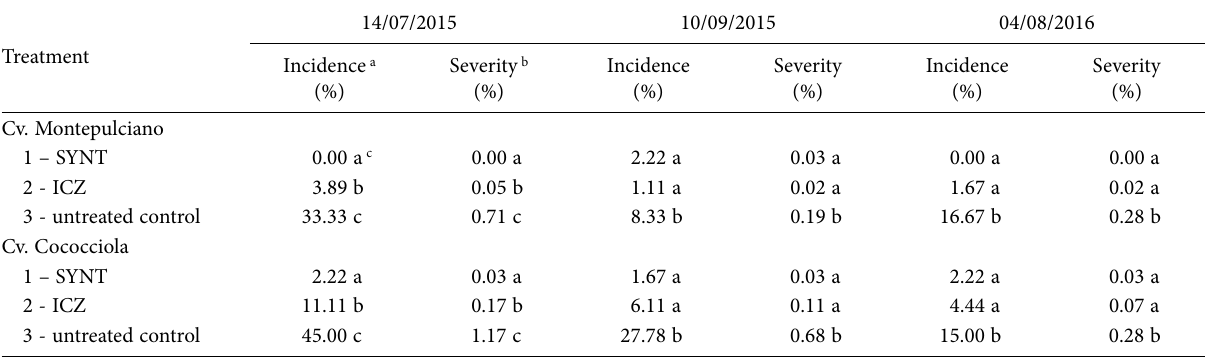
Table 8. Activity of Italian chabasite-rich zeolitites (ICZ) and synthetic insecticides (SYNT) on grapevine moth bunch infestations in the cv. Montepulciano and Cococciola in the Ari vineyard in the surveys carried out at the 2 nd moth generation: 14/07/2015 and 04/08/2016, and at the 3 nd moth generation on 10/09/2015.